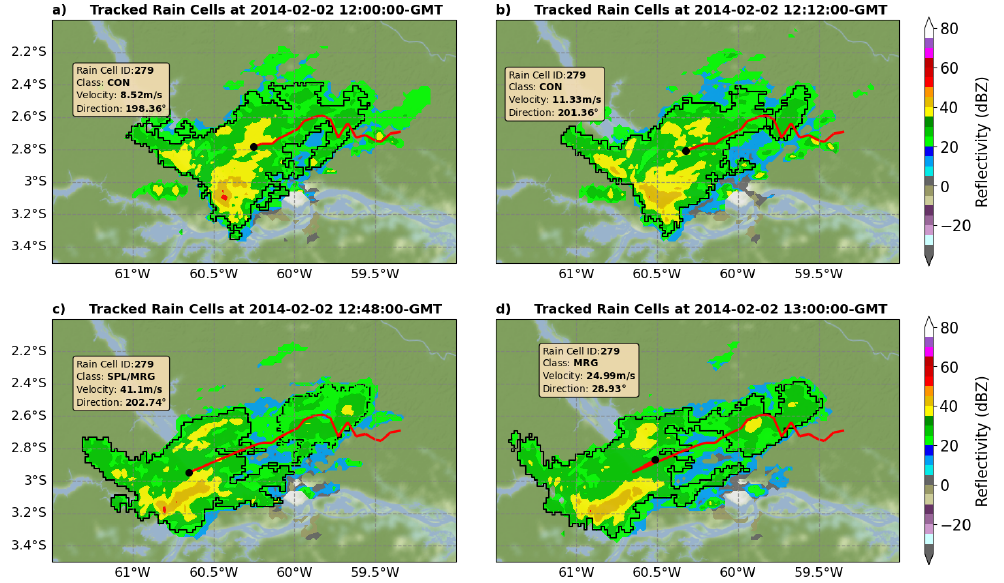
Figure 3. Observed rain cell (SIPAM RADAR reflectivity) tracking over the Amazon region during February 2, 2014 at: ( a ) 12:00 GMT; ( b ) 12:12 GMT; ( c ) 12:48 GMT; and ( d ) 13:00 GMT. The red line shows the trajectory in previous times. The legend of each panel gives information about the rain cell: Identification (ID); Classes of Interactions (Class); Velocity and direction of the current